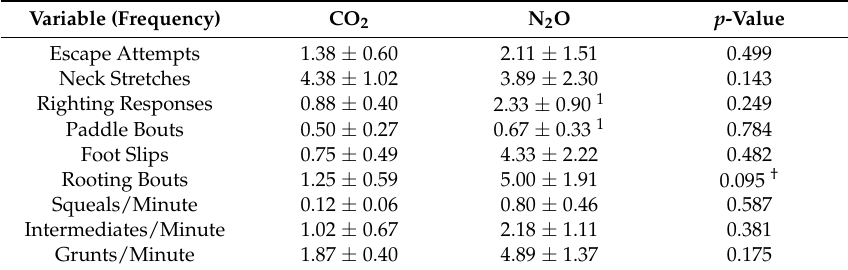
Table 4. Frequency of events collected (mean ± SE) on individual piglets during Experiment